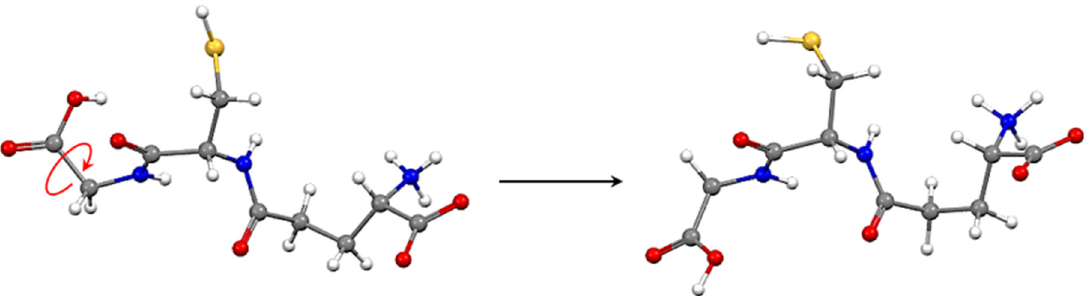
Figure 5. Torsion of the carboxyl group, -COOH, of the glycine portion in the glutathione molecule, and the overlapping of their molecular structures from the peptide bond that joins the glycine chain to the cysteine chain.